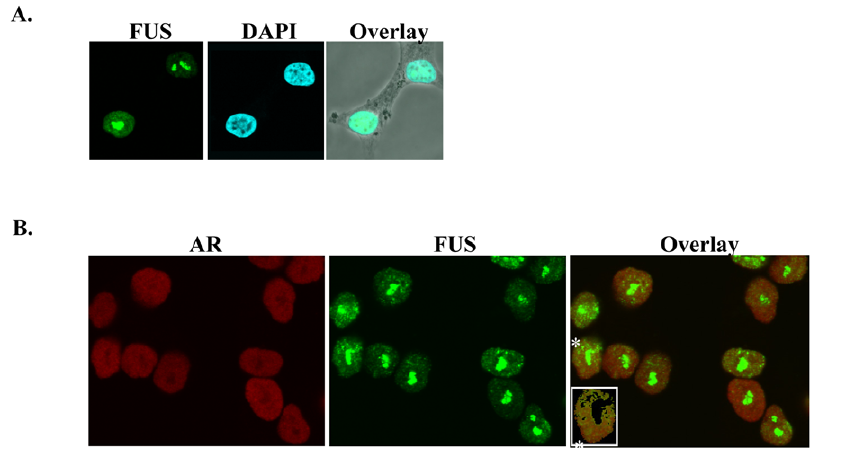
Figure 2. Subcellular localization of FUS in prostate cancer cells. ( A ) Nuclear localization of FUS in LNCaP cells. Cells were treated with R1881 (10 nM) for 3 hrs. Confocal immunofluoresence was performed using anti-FUS antibody (green) and cells were counterstained with DAPI (blue). ( B ) Colocalization of AR and FUS. Dual staining shows co-localization of AR (red) with FUS (green) in LNCaP cells treated with 10 nM R1881 for 3 hrs. The inset in the right panel represents the cell designated with (*) after threshold gating to remove the bright central green spot.